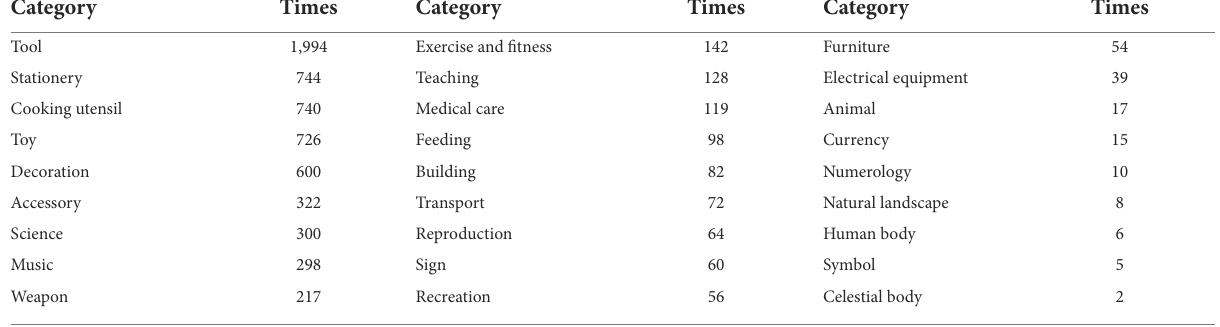
TABLE 2 Category and number of responses to S-AUT.